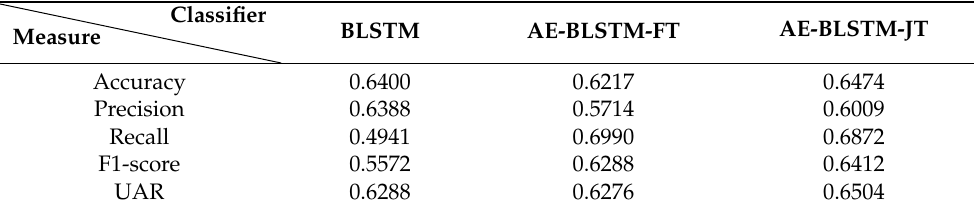
Table 2. Classification results of conventional classifiers using eGeMAPS features, such as BLSTM, AE-BLSTM-FT, and AT-BLSTM-JT